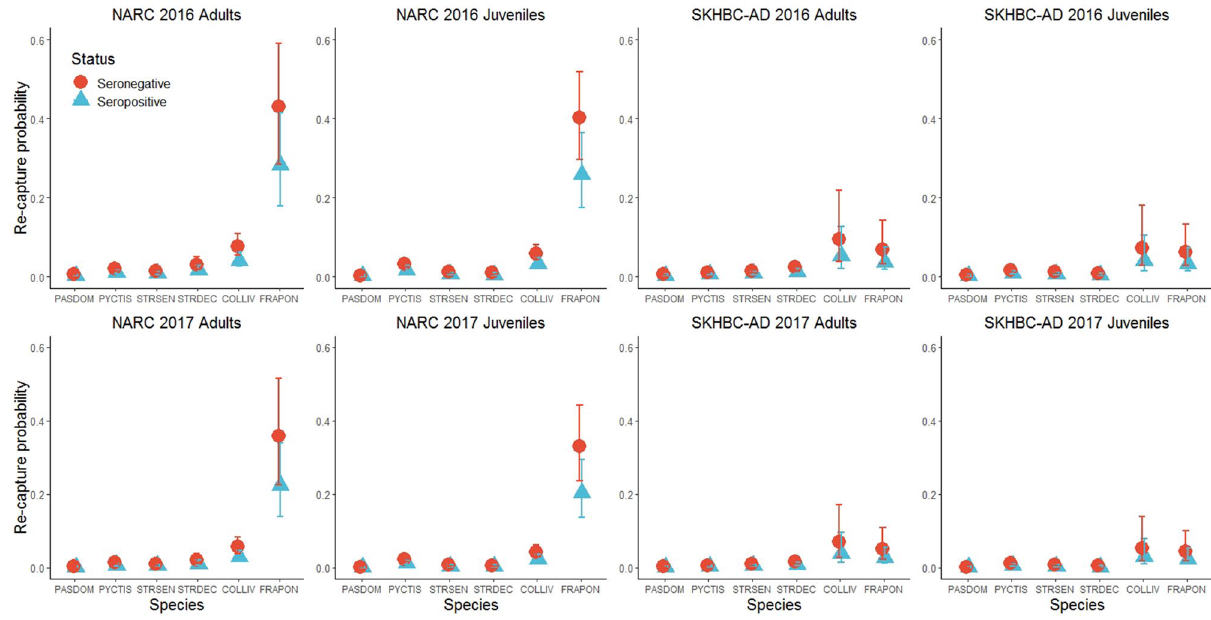
Figure 4. Re-capture probabilities for each bird species according to the age and serological status of the individuals and to the site and the year of sampling. PASDOM stands for Passer domesticus , PYCTIS for Pycnonotus leucotis , STRSEN for Spilopelia senegalensis , STRDEC for Streptopelia decaocto , COLLIV for Columba livia and FRAPON for Francolinus pondicerianus. Error bars represent 95% confidence intervals.